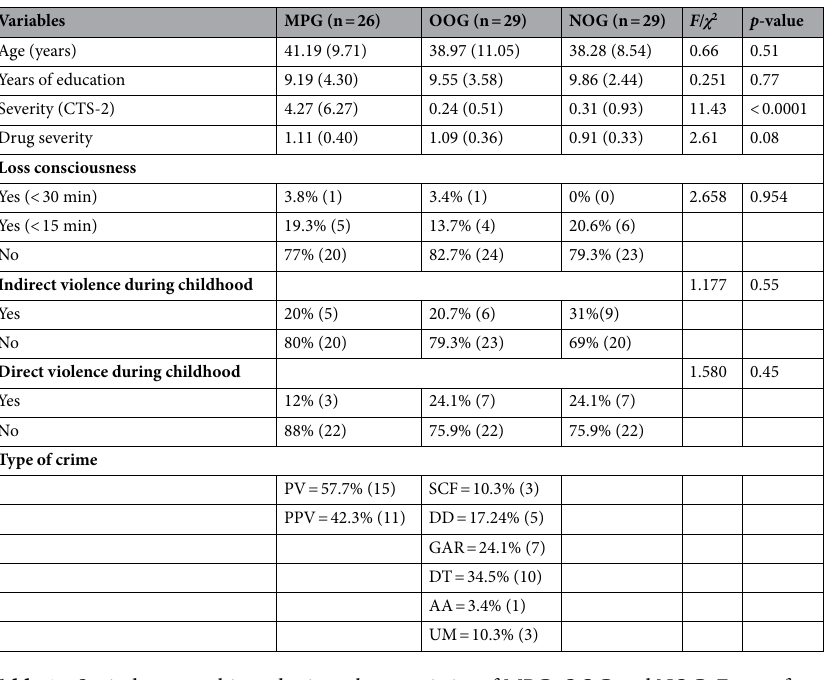
Table 1. Sociodemographic and crime characteristics of MPG, OOG and NOG. Except for type of crime, violence during childhood and loss of consciousness, all values are mean (± SD). MPG male perpetrators group, OOG other offenders group, NOG non-offenders group, CTS‑2 Conflict Tactic Scale-2, Indirect violence witnessing violence during childhood, Direct violence experiencing violence during childhood, PV psychological violence, PPV physical and psychological violence, SCF scams or crimes of forgery, DD dangerous driving, GAR Grave assault/robbery, DT drug trafficking, AA attack on authority, UM unspecified misdemeanor (lost